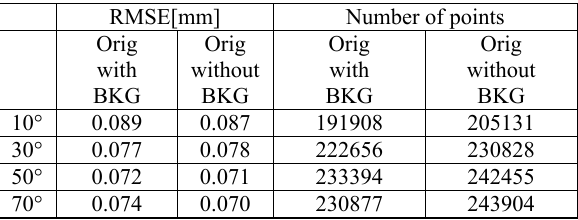
Table 6: Comparison between the images with/without BKG in terms of RMSE and Number of points